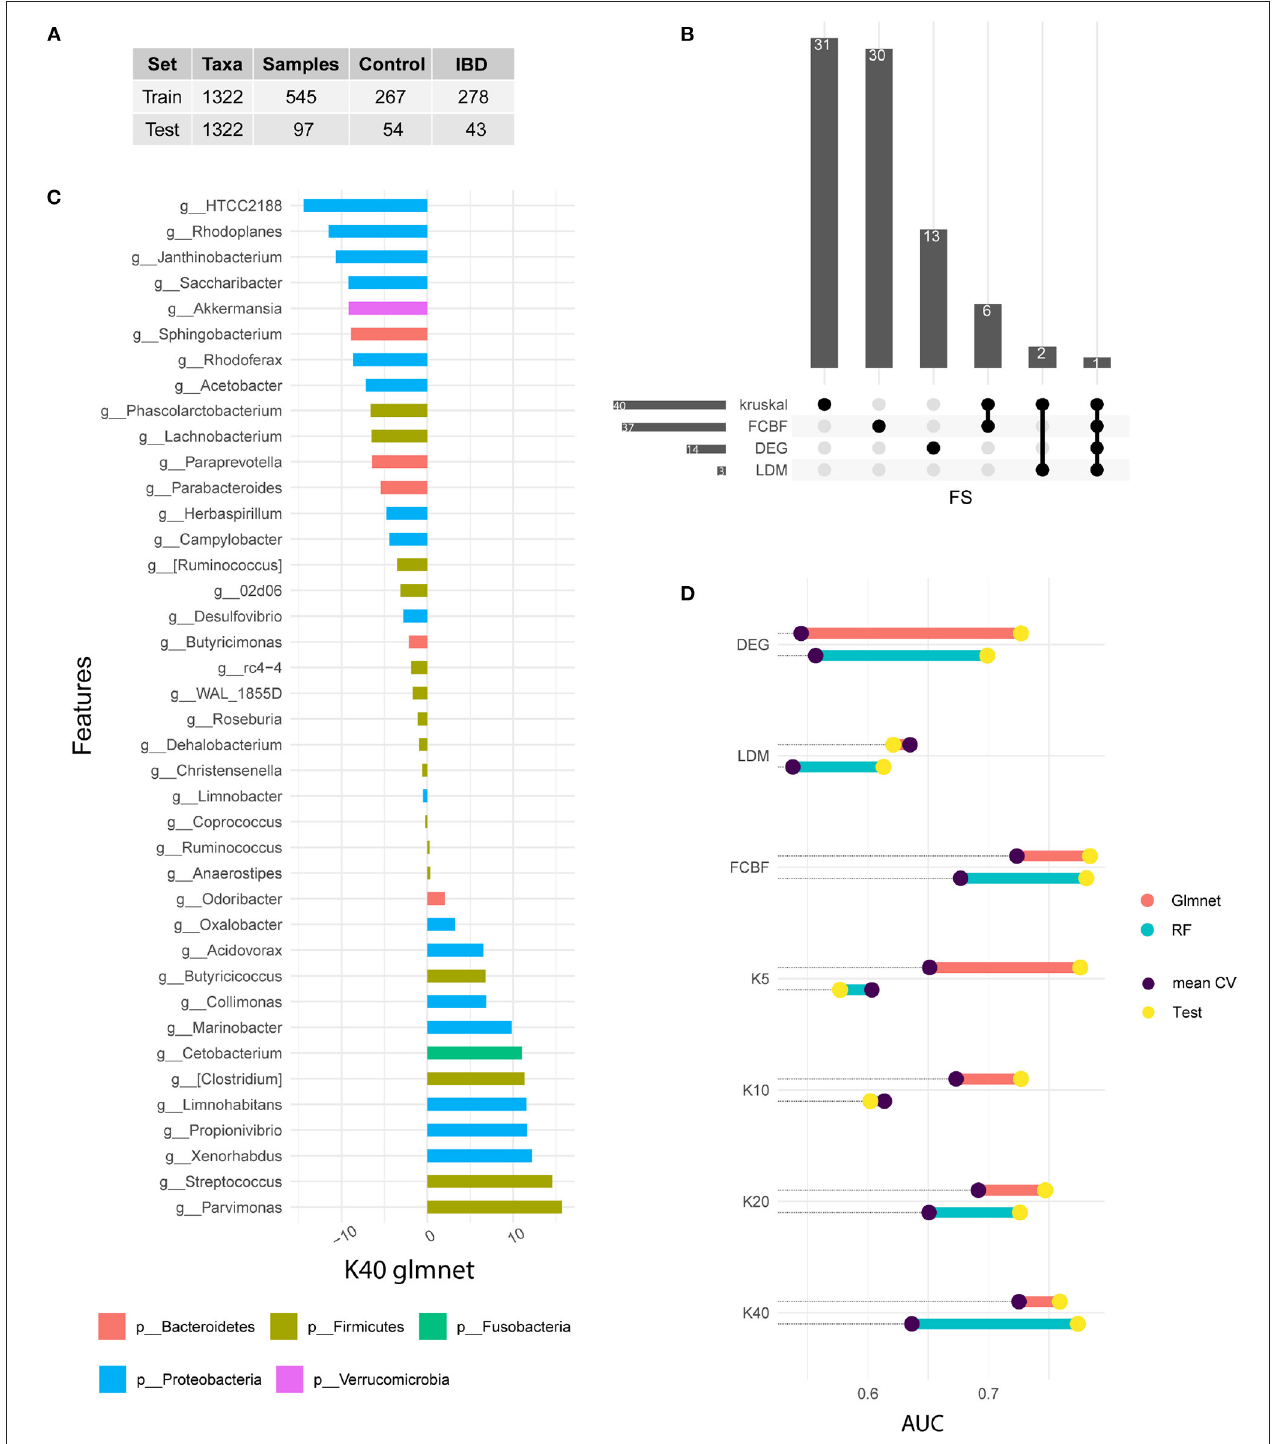
FIGURE 1 | Signature identification. (A) Training and test data available from the American Gut Project for IBD samples. (B) Upset plot indicating the common features selected by each FS method. (C) Variable importance of the winning model measured after cross-validation. In this case, the 40 genera selected by the Kruskal Wallis method are shown. The bars represent the importance of the variables within the glmnet model. This was done by summing the betas of each variable over all iterations of the CV. (D) Comparison of the performance of the models in train and test. Note that the train value is the result of the arithmetic mean of the five iterations of the CV, while the test result is a single measure. The results of the glmnet and RF models are shown in AUC value.